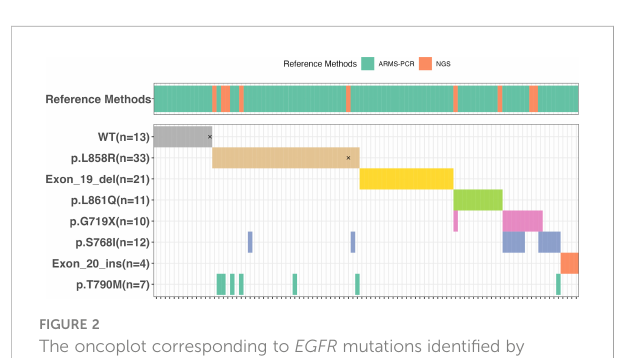
FIGURE 2 The oncoplot corresponding to EGFR mutations identi fi ed by Idylla ™ assay in the 95 samples that were subjected to the reference methods ARMS-PCR or NGS. The discordances were marked by “ × ” .